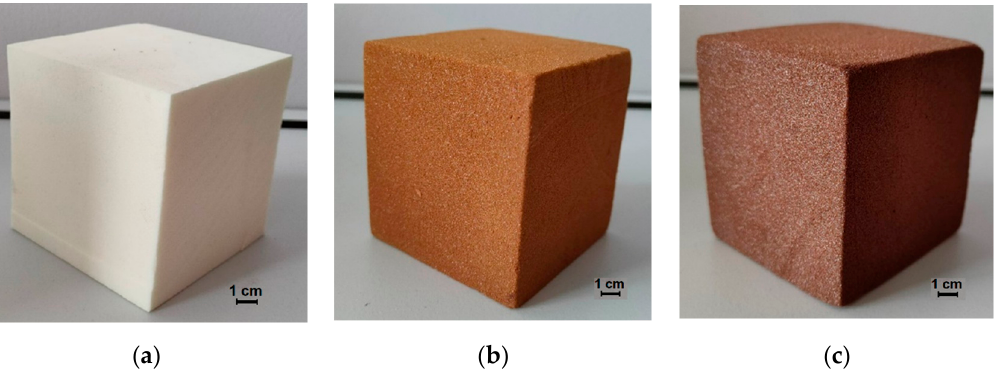
Figure 5. The macroscopic pictures of PUFs before ( a ) and after thermal exposure in temperature 150 ( b ) and 175 °C ( c ) (cube has the shape of a cube with a side of 10 cm). Annealing of PUF resulted in mass loss of samples, mostly in first day of heating (Figure 6).